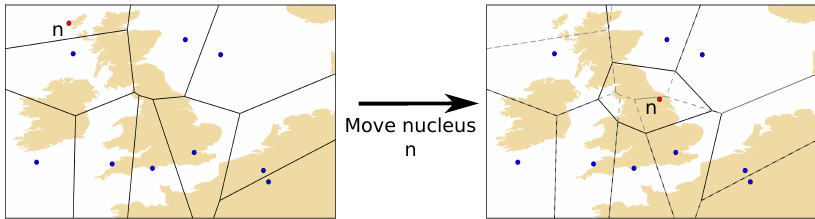
Figure 1. A spatial domain partitioned into 10 Voronoi cells. Moving one nucleus to a new position in the domain changes the boundaries of the neighbouring